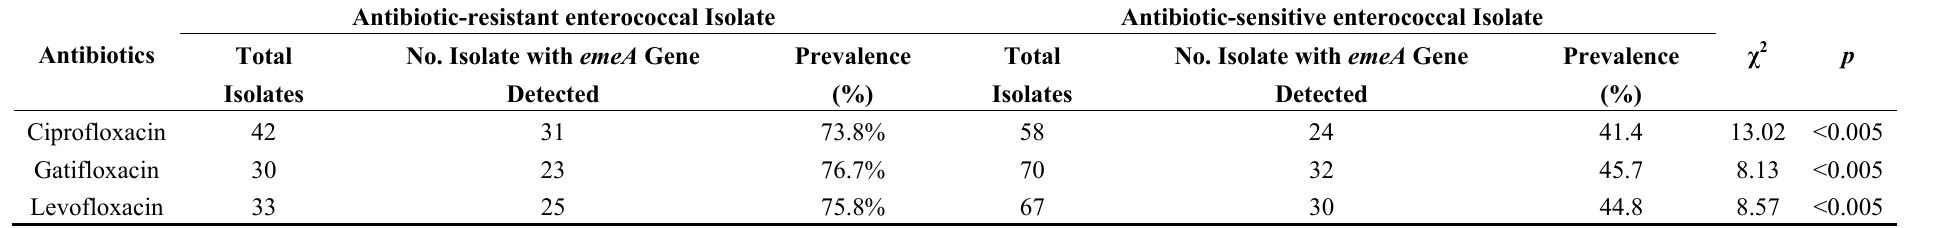
Table 10. Prevalence of the emeA gene in multiple-drug resistant enterococcal